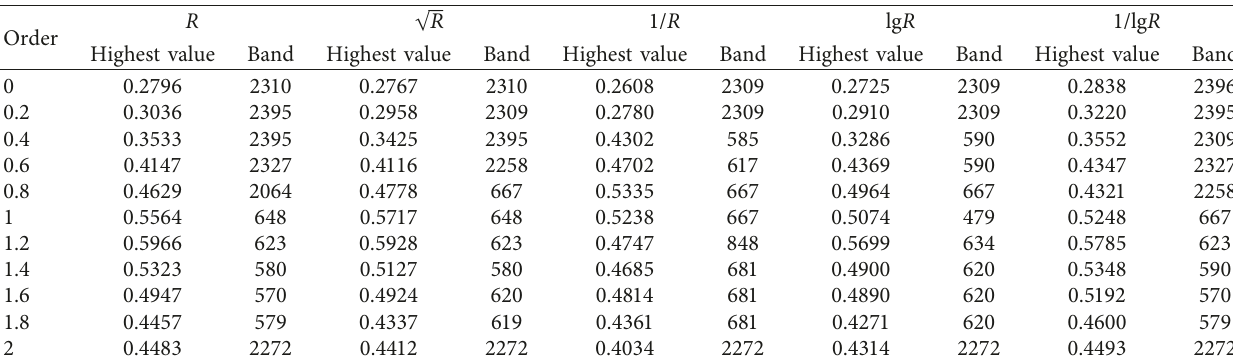
Table 2: Bands with the highest absolute correlation coefficient value in each spectral